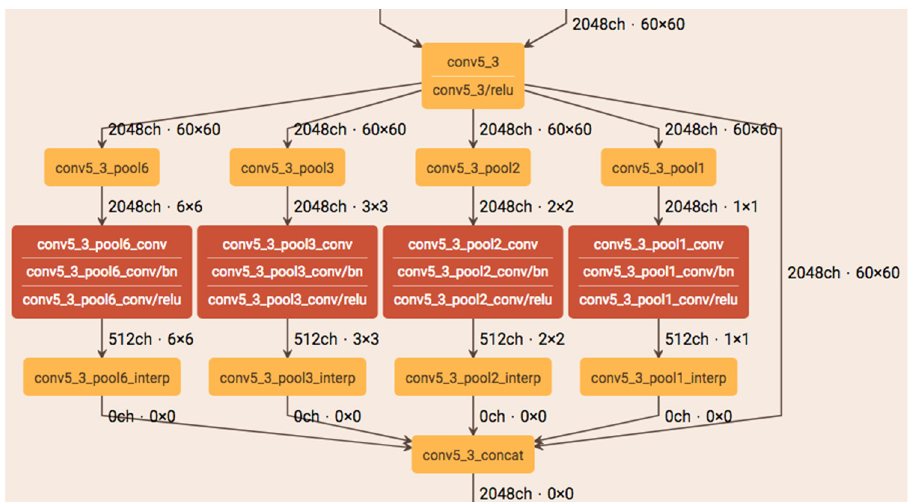
Figure 2. PSPNet network.